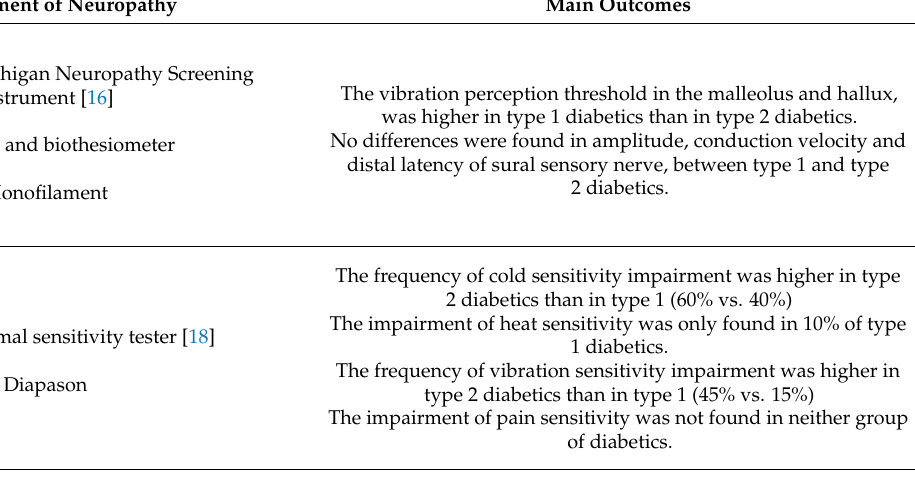
Table 1. Differences between type 1 (T1) and type 2 (T2) diabetes in sensory neuropathy.